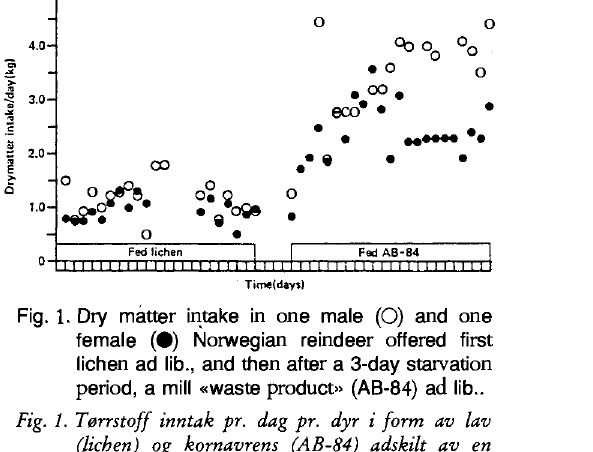
Fig. 1. Dry matter intake in one male (O) and one female (•) Norwegian reindeer offered first lichen ad lib., and then after a 3-day starvation period, a mill «waste product" (AB-84) ad lib.. Fig. 1. Terrstoff inntak pr. dag pr. dyr i form av lav (lichen) og kornavrens (AB-84) adskilt av en periode uten mat for en bukk (O) og en simle